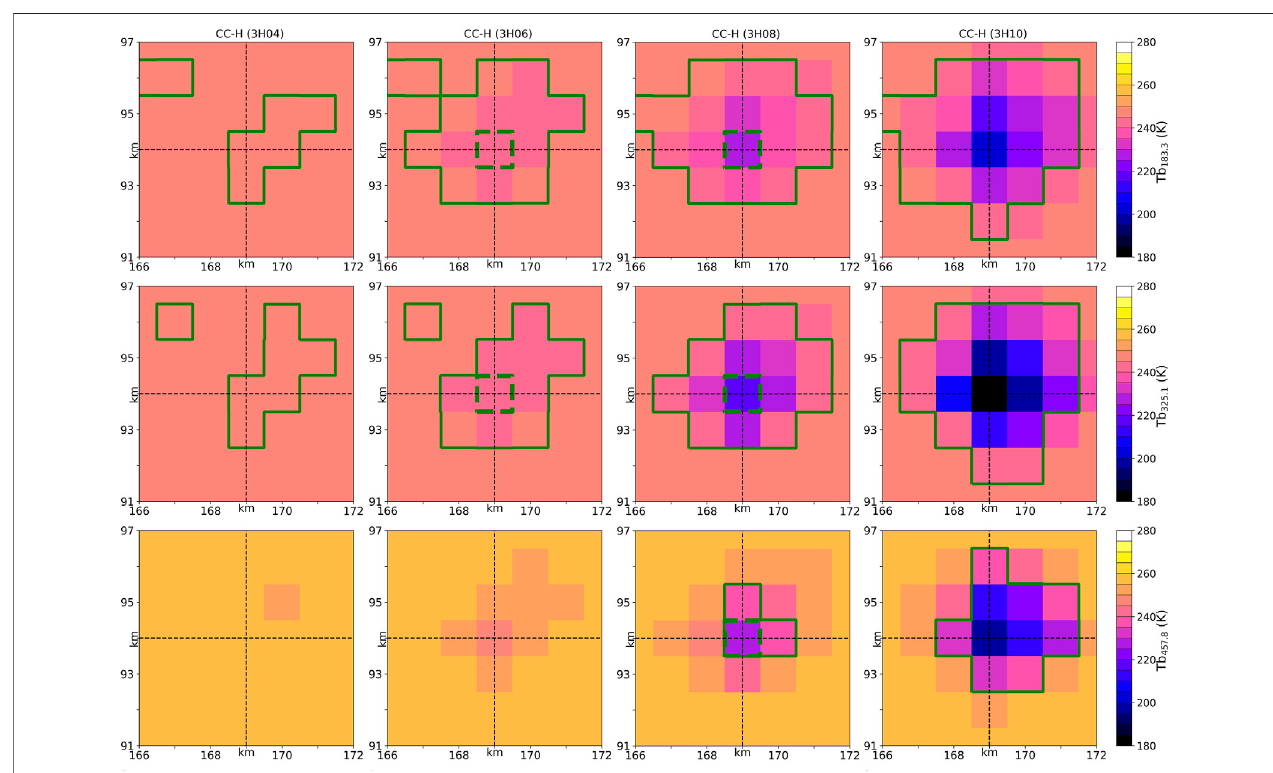
FIGURE 5 | same as in Figure 4 but for Tb at 183.3, 325.1, and 457.8 GHz. The green solid line shows the boundary where the deep convection criterion is satis fi ed and the dashed line where the growing convective core criterion is satis fi ed.